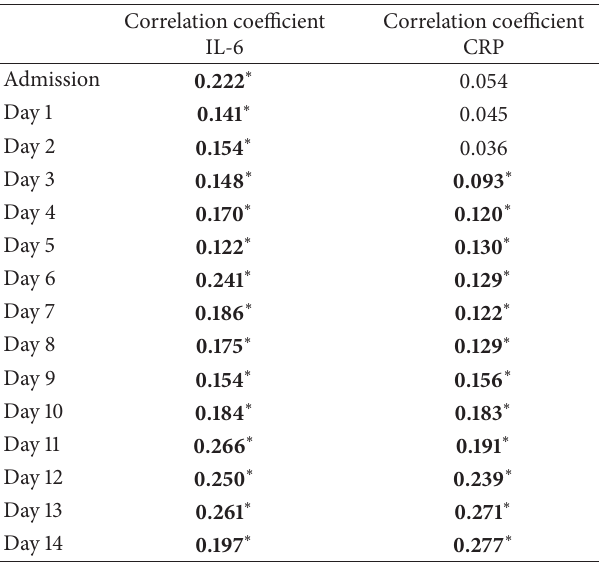
Table 6: Correlation of systemic plasma IL-6 and CRP values with the incidence of MODS during the clinical